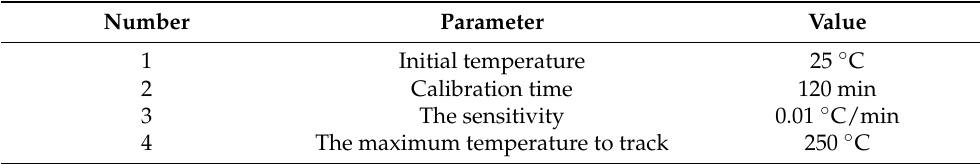
Table 1. ARC parameter settings for the “Adiabatic Test” mode.